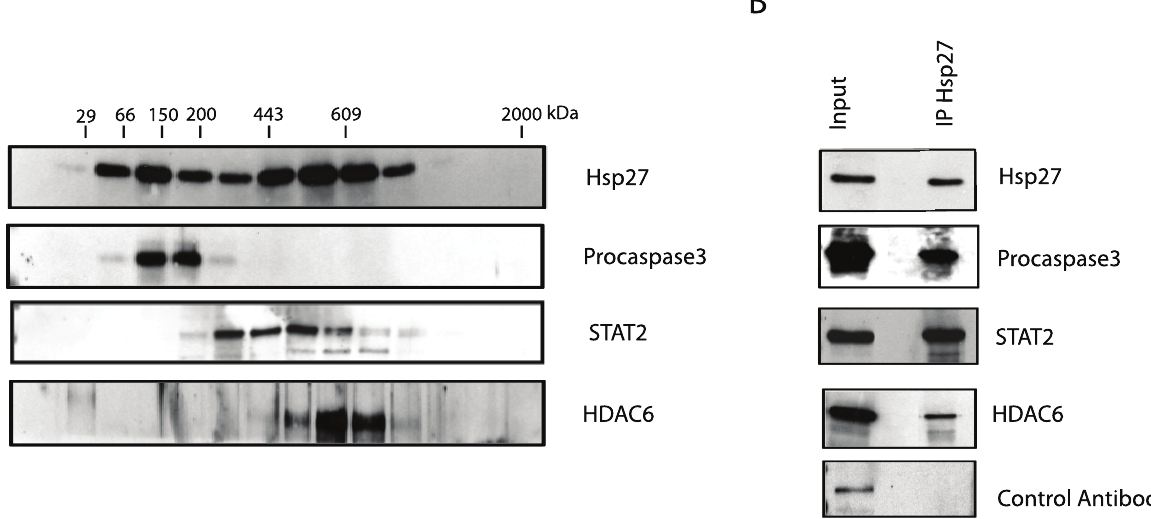
Figure 6. HeLa cells were lysed in the presence of 0.1% Triton X-100 and the 10,000 6 g soluble supernatants were applied to sepharose CL-6B gel filtration columns as described in Materials and methods. 29, 66, 150, 200, 443, 669 and 2000 (kDa) indicate the apparent native size of gel filtration markers. A , The presence of Hsp27, HDAC6, STAT2 and procaspase-3 in pooled fractions eluted from the columns was detected by western blot analysis. B , interactions between Hsp27 and client proteins analyzed by Co-IP experiments using a goat polyclonal anti- Hsp27 antibody. Column fractions corresponding to either procaspase-3, STAT2 or HDAC6 were pooled and used for immunoprecipitation. Immunoprecipitated proteins and input cell lysates were analyzed side by side in immunoblots probed with the indicated antibodies. A representative negative control of Co-IP was performed with a control antibody and revealed (here the anti procaspase 3).